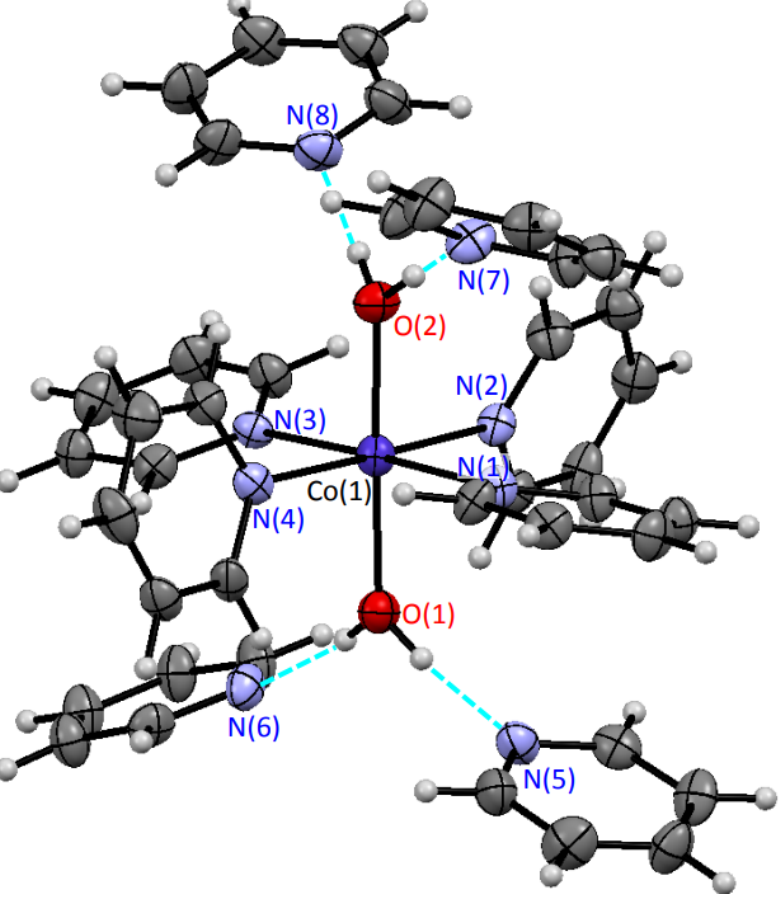
Figure 4. Crystal structure of [Co(H 2 O) 2 (py) 4 ] 2+ ·4py unit in 2 . Thermal ellipsoids are drawn at the 50% probability level. Table 4. Selected distances for 2